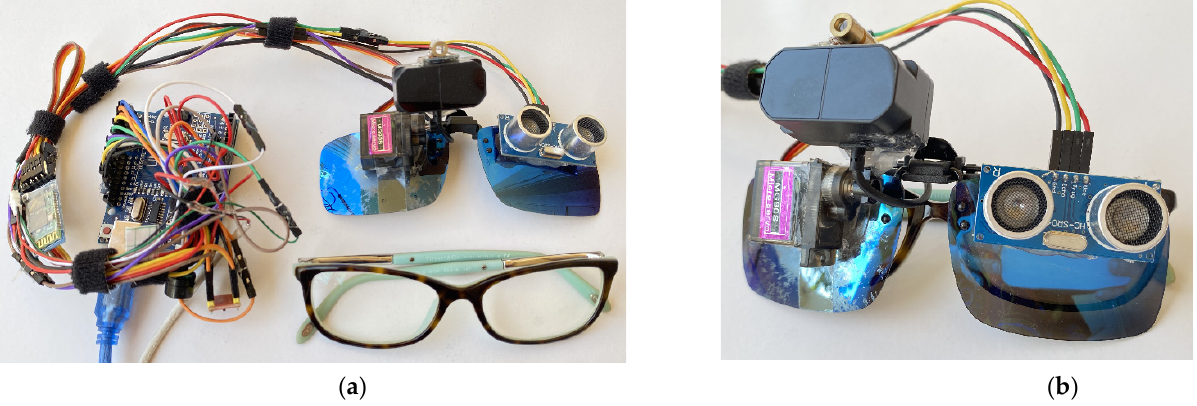
Figure 7. ( a ) LidSonic V2.0 device and a glass ( b ) LidSonic V2.0 device mounted into a glass